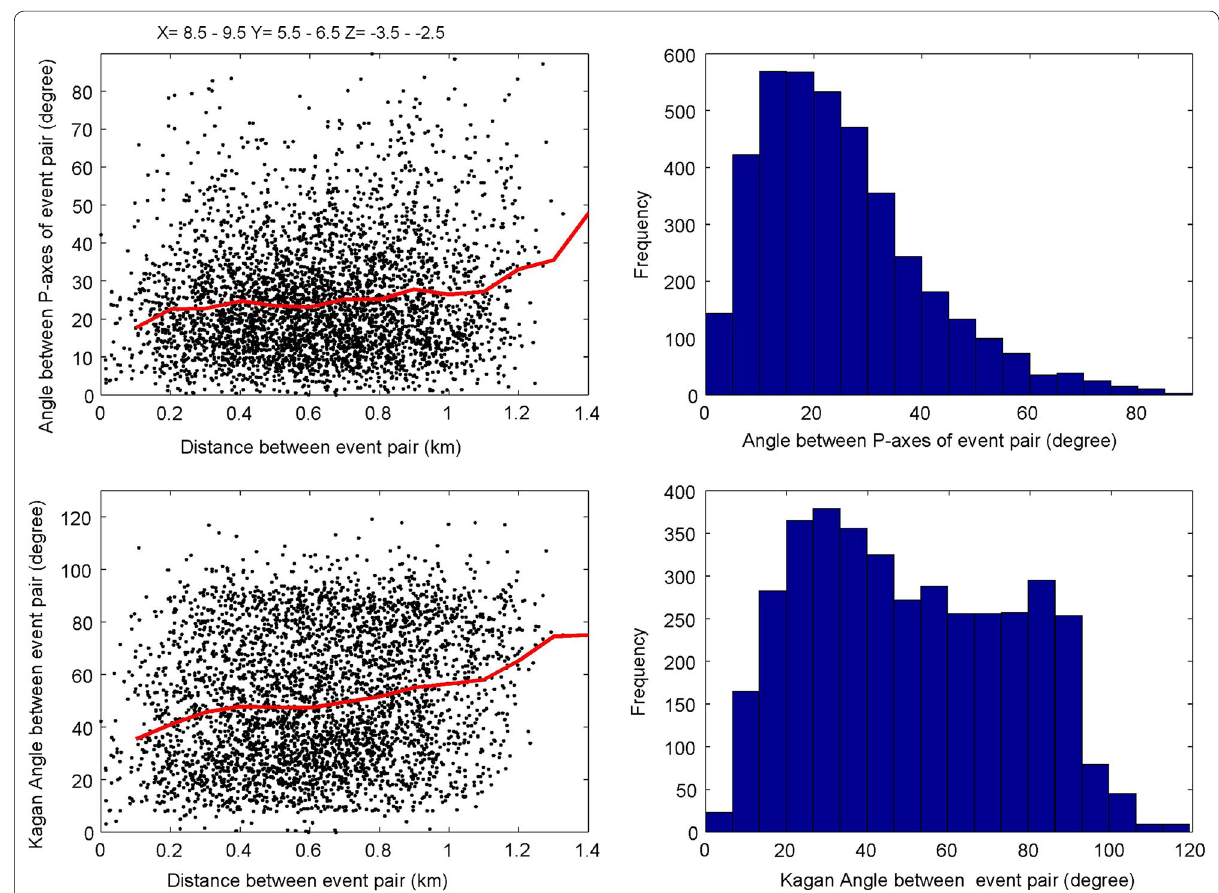
Fig. 14 (Upper) Relationship between focal distance and the difference in P -axis orientations (the angle between two P -axes) for each event pair at a grid point ( x 9, y 6, z 3), and the frequency distribution of angles between two P -axes of each event pair. (Lower) Similar plots for Kagan = = = − angles between focal mechanisms of each event